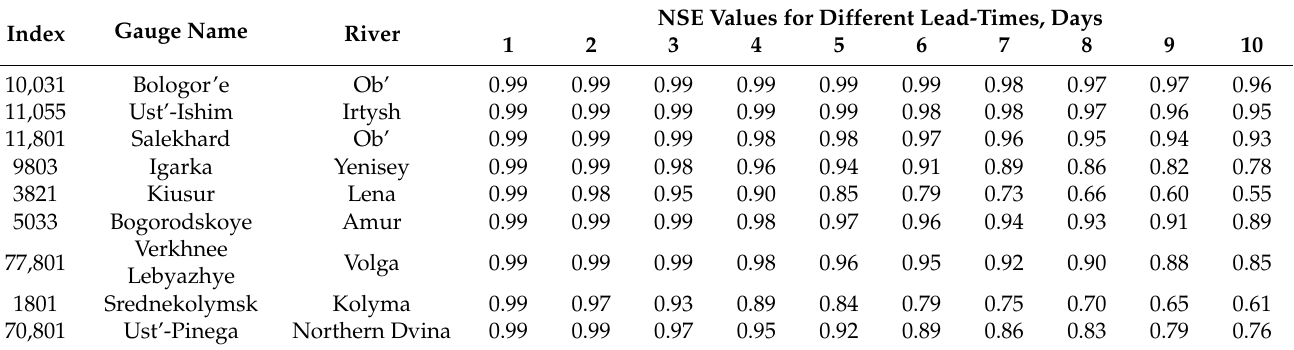
Table 2. NSE values for daily flow forecasts at major gauging